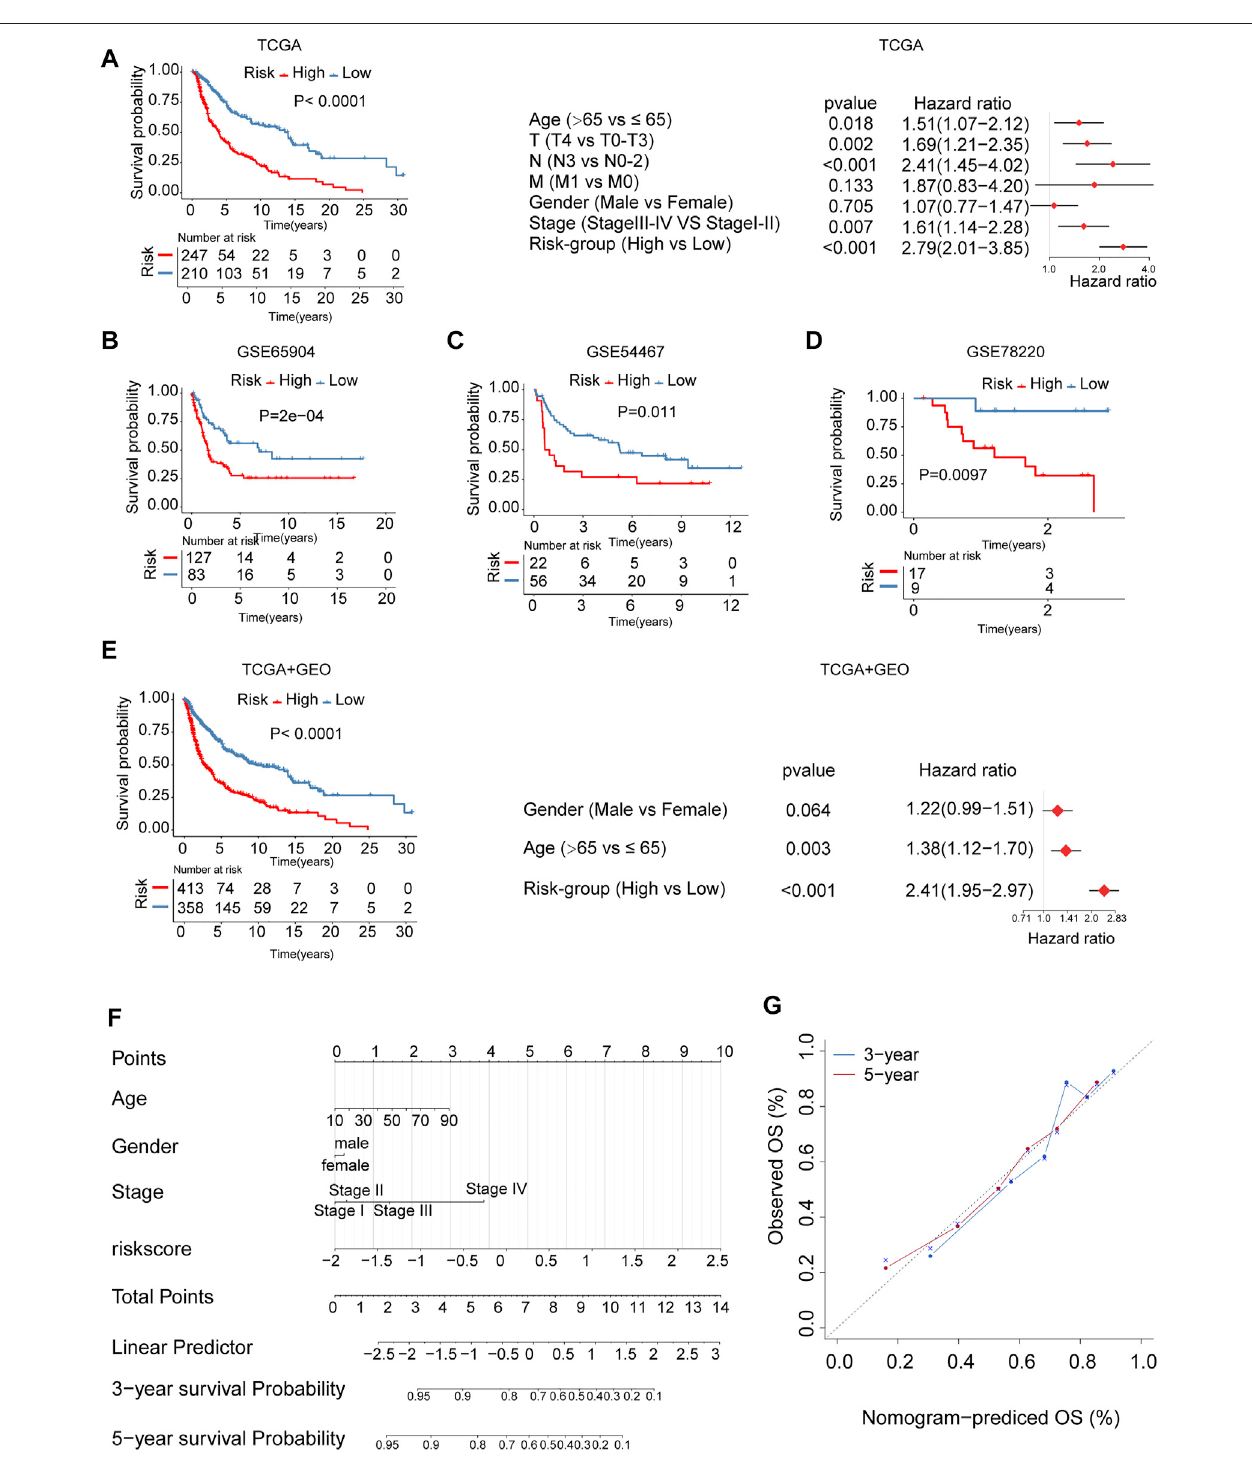
FIGURE 6 | The m6A-related signature and the nomogram in the role of survival prediction. The Kaplan Meier plots for survival prediction of high-risk and low-risk. Forest plot representation of the multivariate Cox regression analysis of risk signature with age, gender, tumor stage was taken into account. (A) TCGA, (B) GSE65904, (C) GSE54467, (D) GSE78220, (E) combined TCGA-GEO. T: T-stage, primary tumor stage; N: N-stage, lymph node; M: M-stage, metastasis. (F) A Nomogram model was established using risk score and well-known risk factors. (G) The calibration curves showed favorable consistencies between the predicted and the actual survival probabilities in 3-, 5-years.